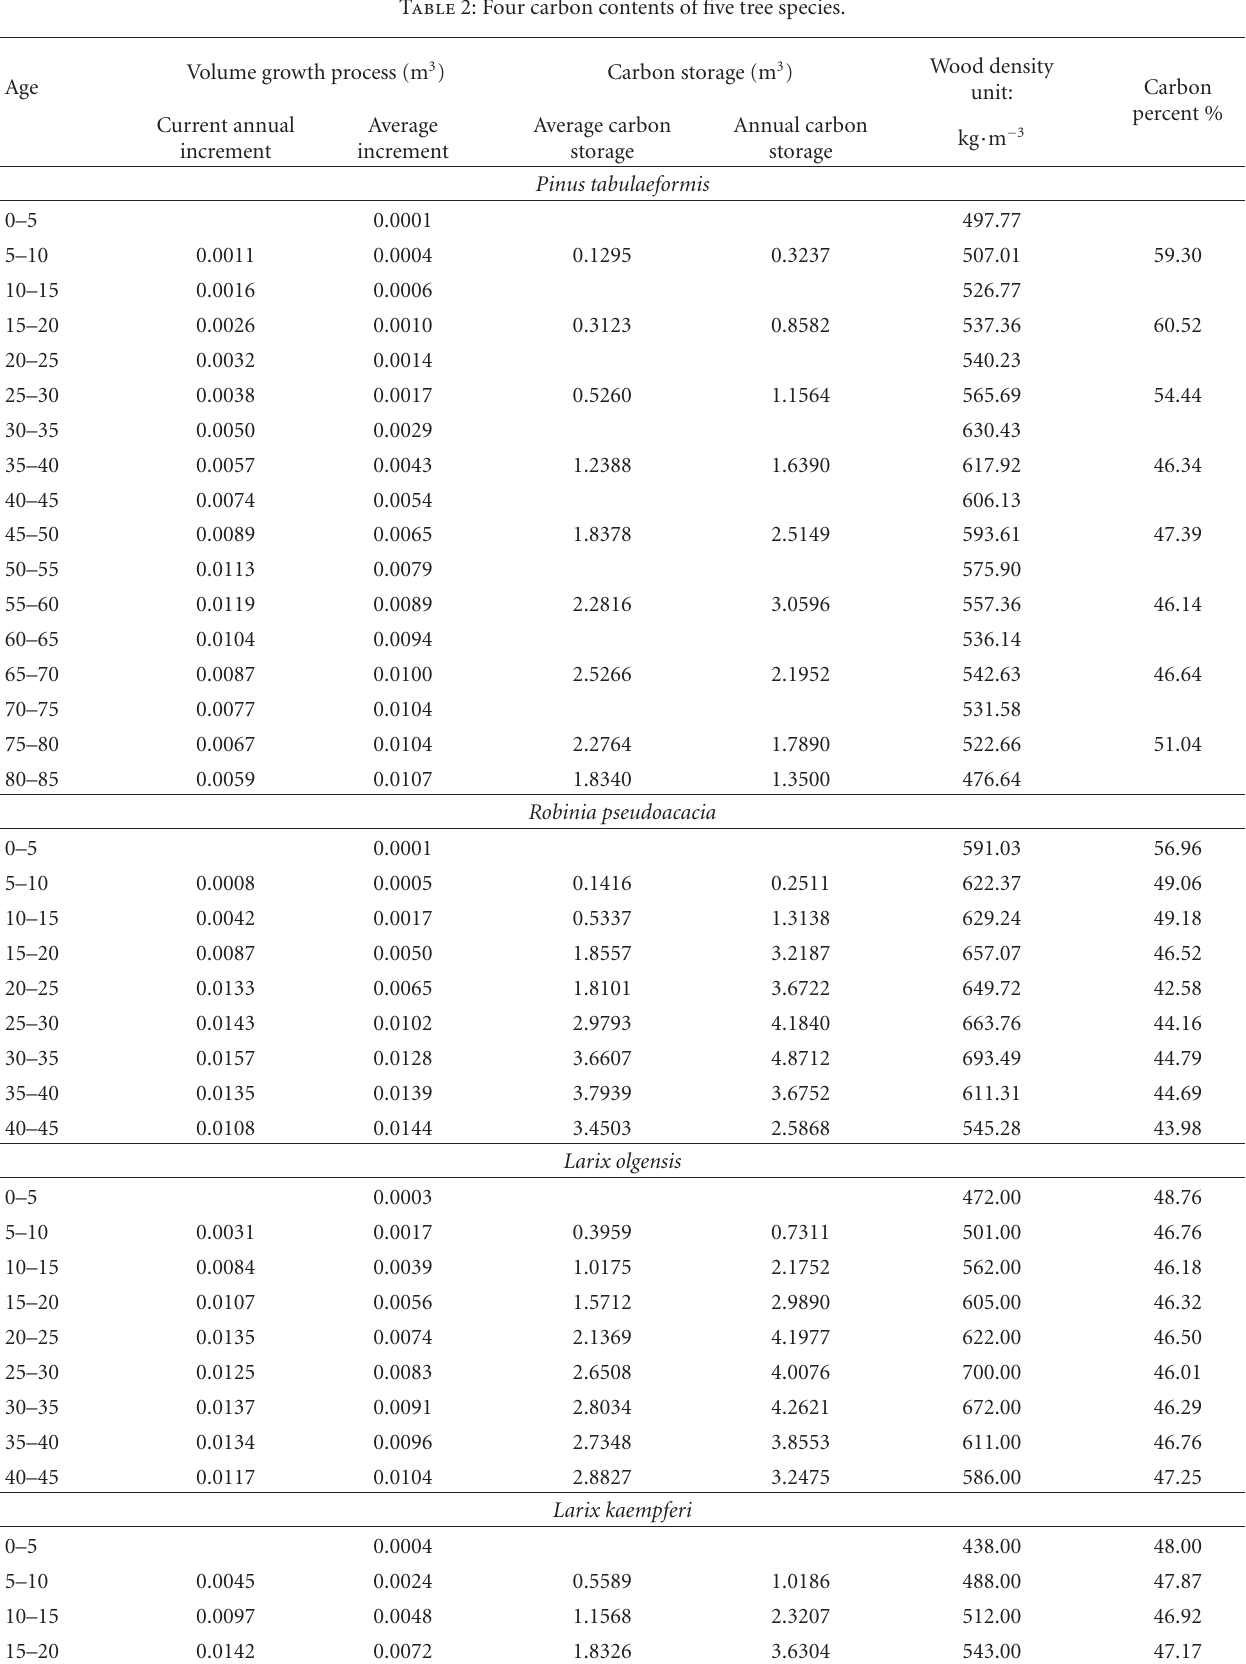
Table 2: Four carbon contents of five tree